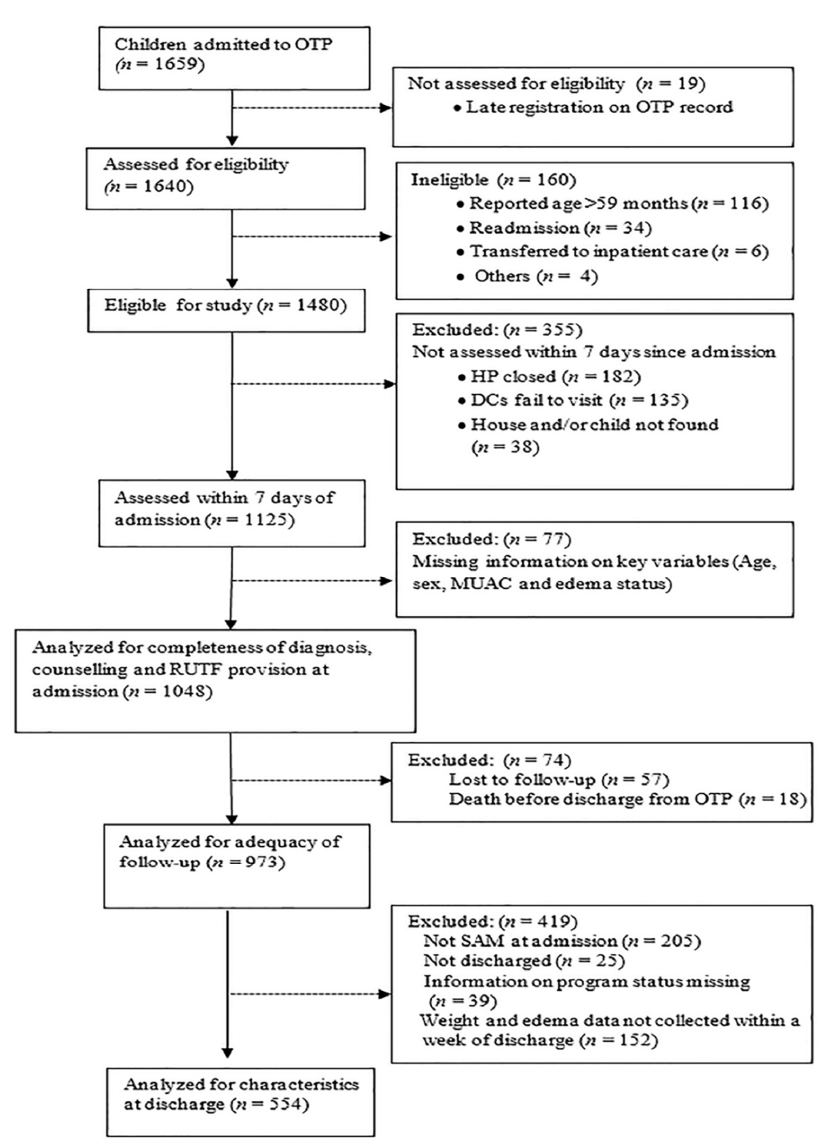
Figure 1. Flow of children admitted to outpatient therapeutic program (OTP). (HP = health post, DC = data collector).